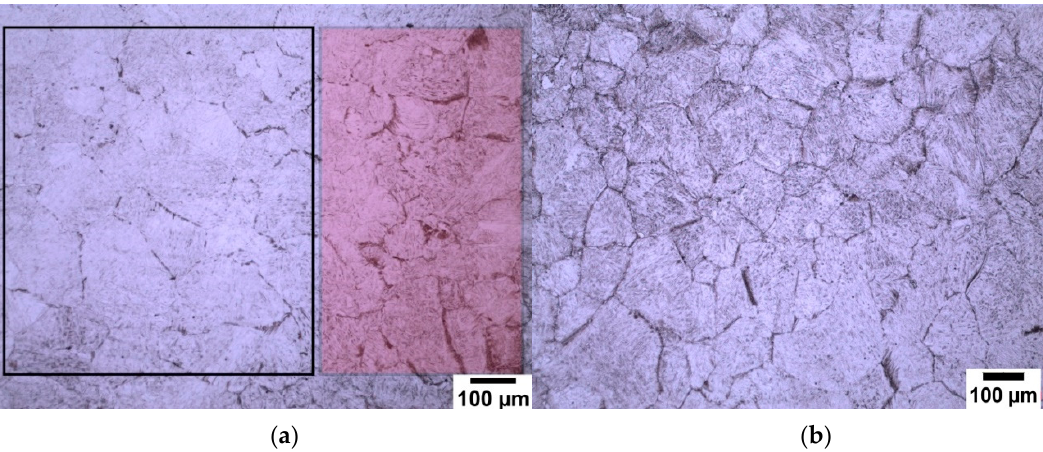
Figure 4. Etching layer e ff ect on 0.8 wt.% carbon steel with 0.005 wt.% Nb at 1100 ◦ C. ( a ) shows the e ff ect of etching layer thickness on the definition of PAGBs and ( b ) shows how the delineation of PAGBs should be when the etching layer is evenly distributed.